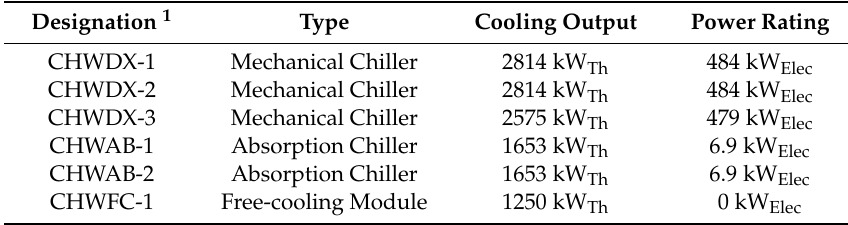
Figure 8. Schematic of the chilled water system. Table 4. Technical specifications of the generation units in the Chilled Water System.